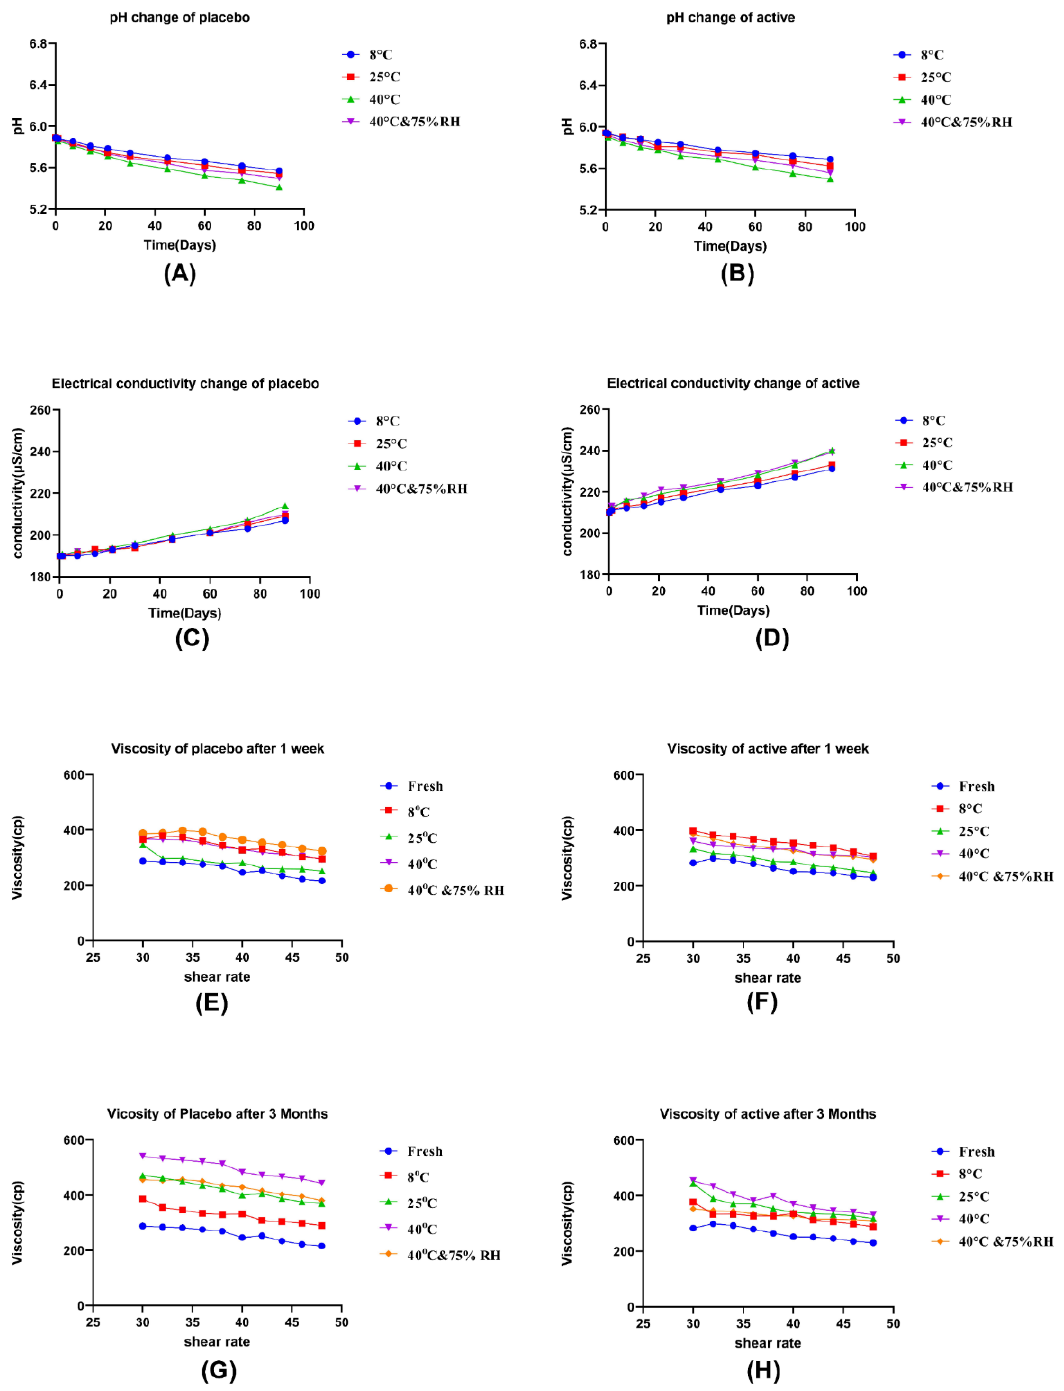
Figure 4. In vitro evaluation for placebo and active microemulgels kept at specified temperature conditions. ( A , B ), pH change; ( C , D ), electrical conductivity change; ( E , F ), viscosity change (a week); ( G , H ), viscosity change (3 months) for placebo and active microemulgels, respectively.